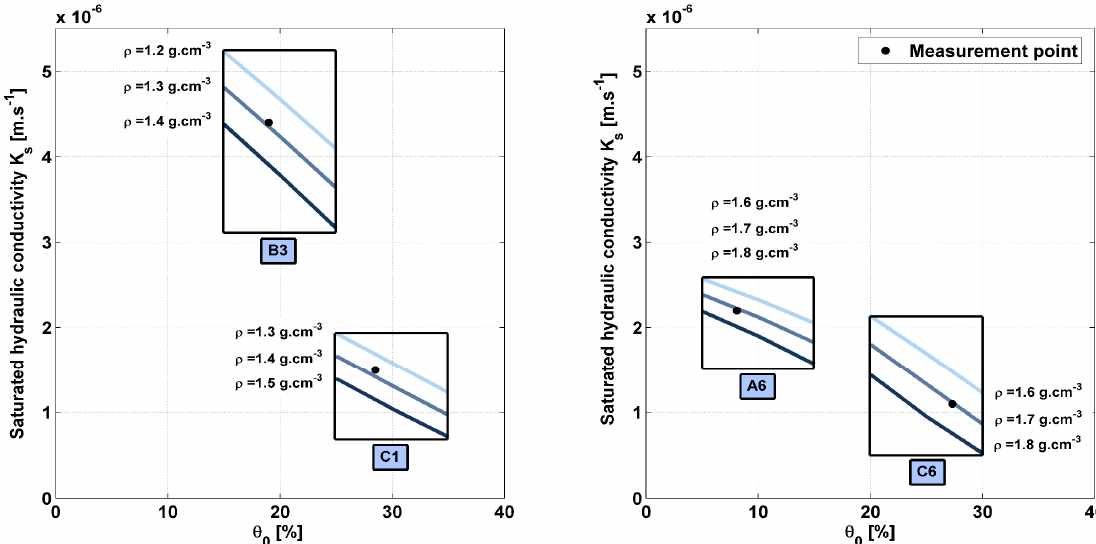
Figure 4. K s sensitivity to θ 0 and ρ in four typical examples from sites A, B, and C. The corresponding results of each individual measurement can be found in Table A1 (Appendix A).